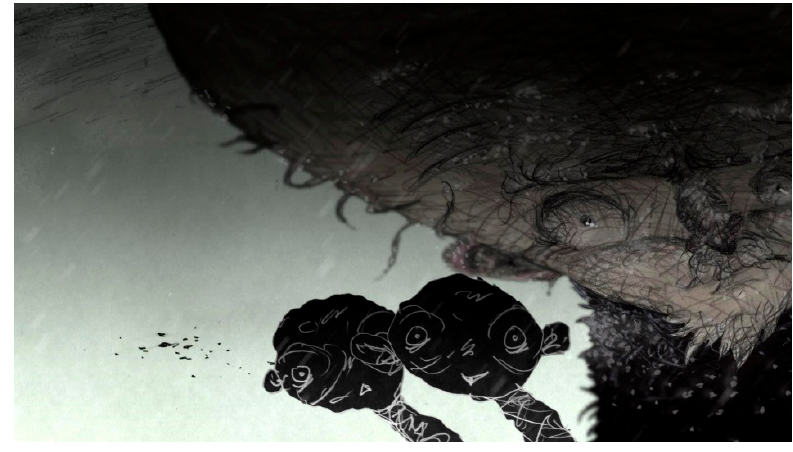
Figure 2. ©YAMAMURA Animation/SHOCHIKU. Figure 2. © YAMAMURA Animation /